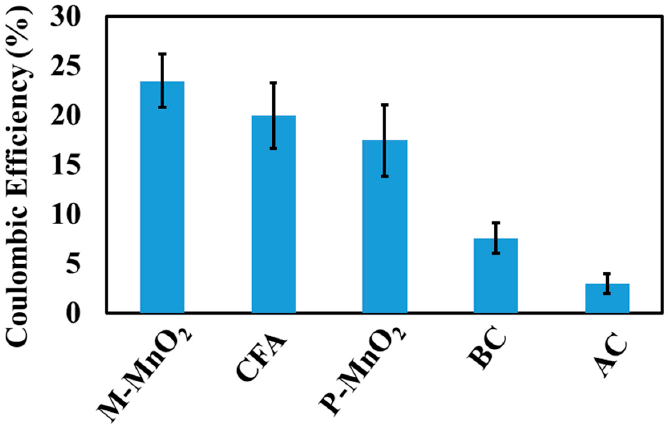
Figure 5. Average CE efficiency values with deviations of the five units with the different cathode assemblies (P-MnO 2 , M-MnO 2 , CFA, BC, AC) versus assemblies (P-MnO 2 , M-MnO 2 , CFA, BC, AC) versus time.